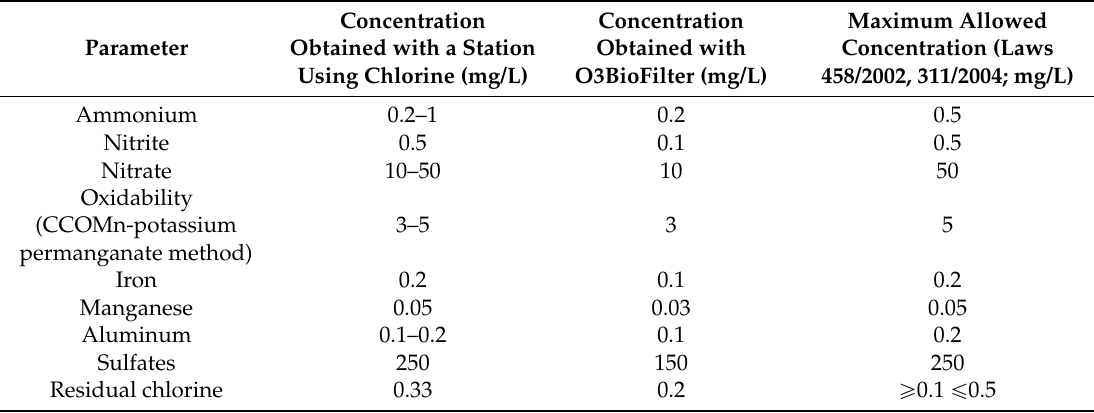
Table 2. Performances of chlorine and O3BioFilter drinking water stations for raw water with heavy loads of pollutants, compared to legal limits